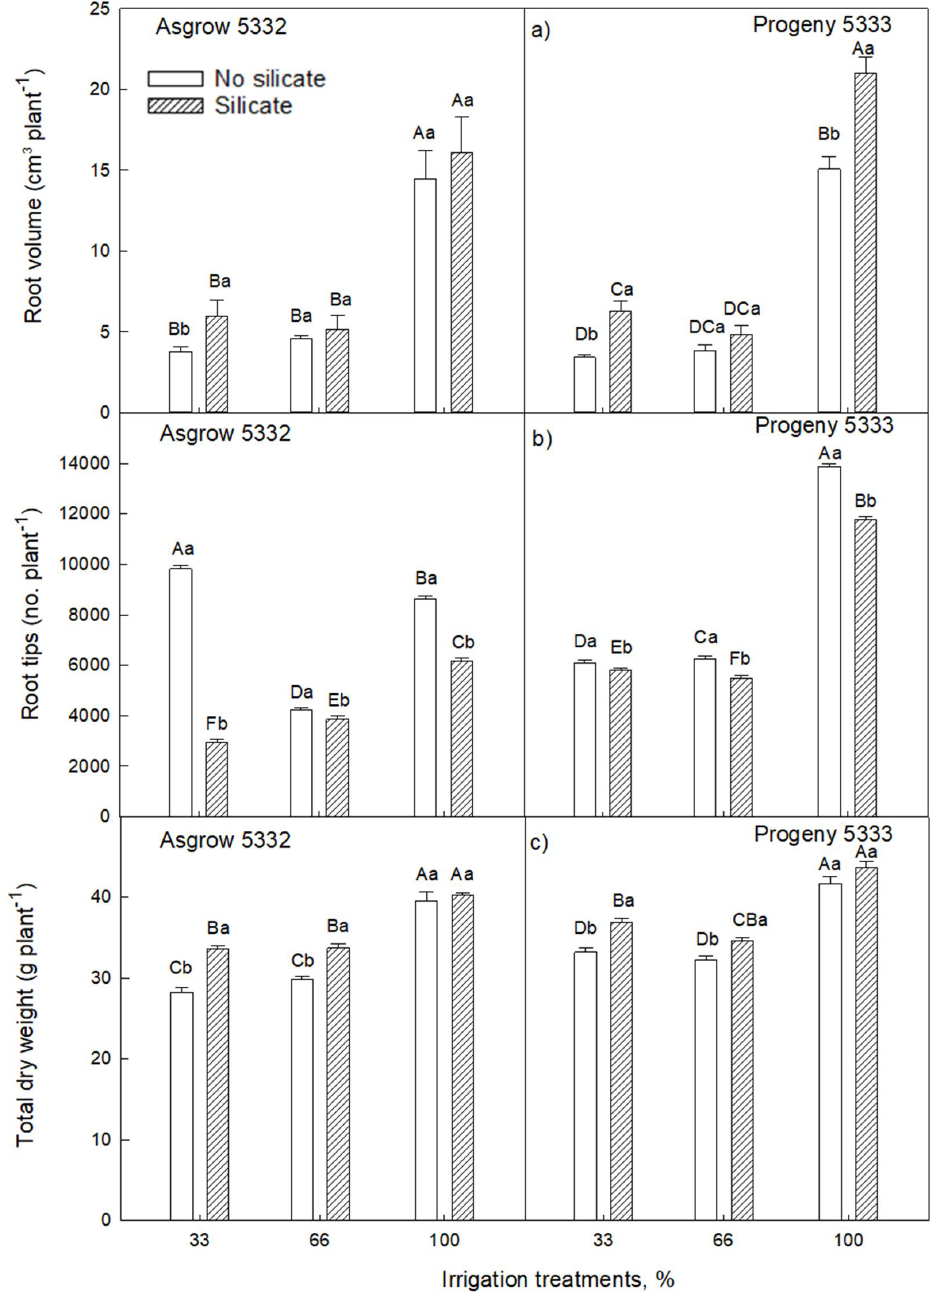
Figure 3. The influence of silicate application on soybean ( a ) root volume, ( b ) root tips, and ( c ) plant total dry weight of three irrigation treatments, measured at 27 days after emergence of the seedling. Three irrigation treatments (33%, 66%, or 100% of required water) were imposed on plants for 20 days. The values are mean and standard errors of five replications in each treatment. The error bars correspond to standard error. The bars followed by the same letters (lower-case letters within silicate and no silicate and upper-case letters within irrigation and silicate treatments) did not differ significantly at 5% by Tukey’s